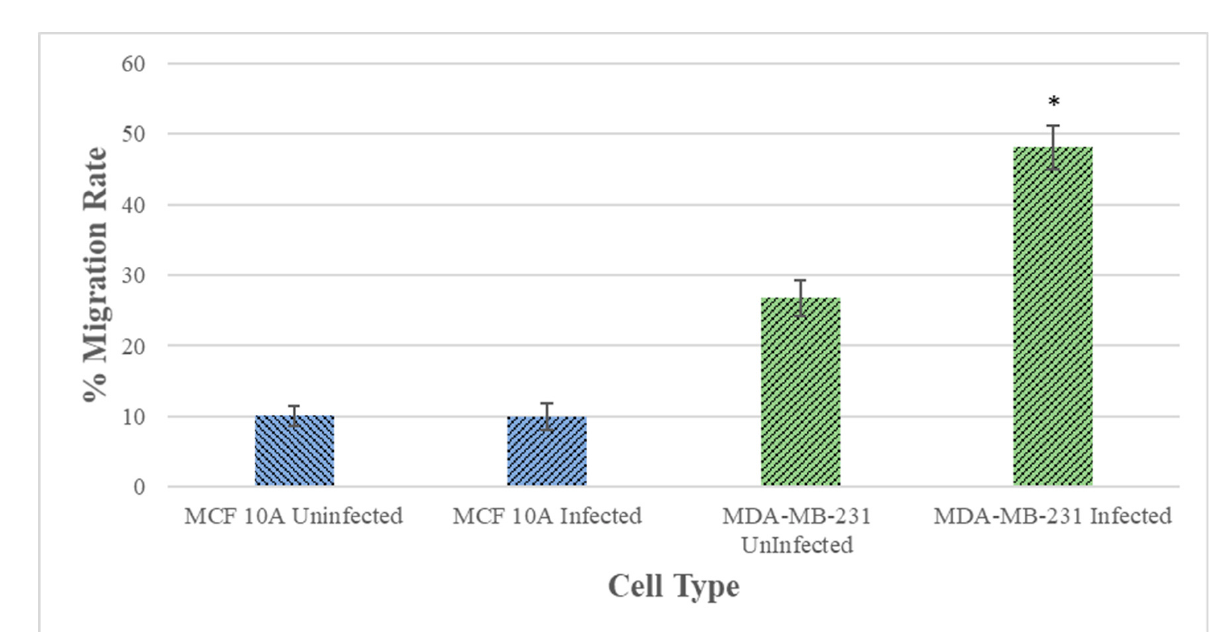
Figure 7. Quantitative analysis of wound healing assay of MCF 10A and MDA-MB-231 epithelial cells after 48 h of infection with B. burgdorferi and 6 h of recovery (48 h + 6 h) . The cells were infected for 48 h with B. burgdorferi and then a wound was induced, and cell migration was quantified after 6 h of recovery as described in Material and Methods. The error bars represent the standard error of mean (SEM). The p -value of the data < 0.05 is considered significant and is indicated by *. All experiments were performed a minimum of four independent times with at least three samples per experiment ( n = 12).